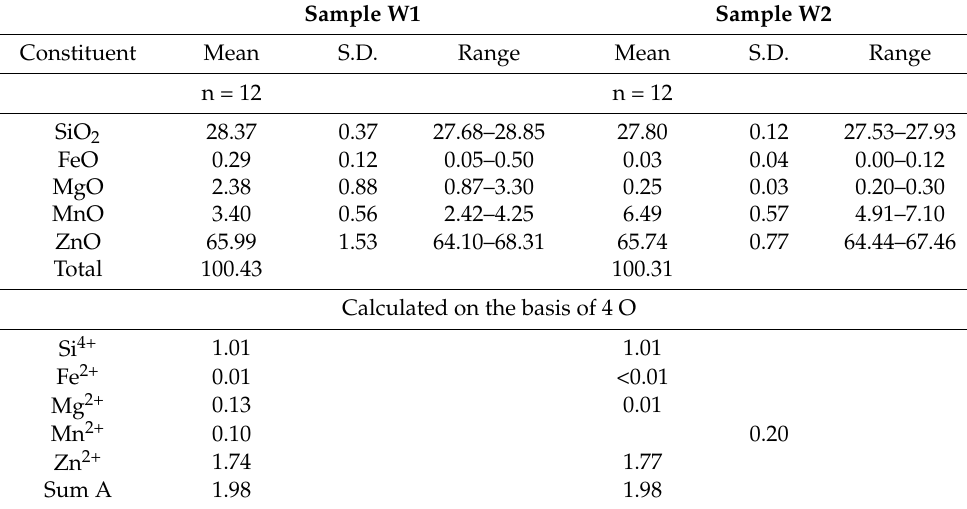
Table 2. Chemical composition (wt.%) of willemite Zn 2 SiO 4